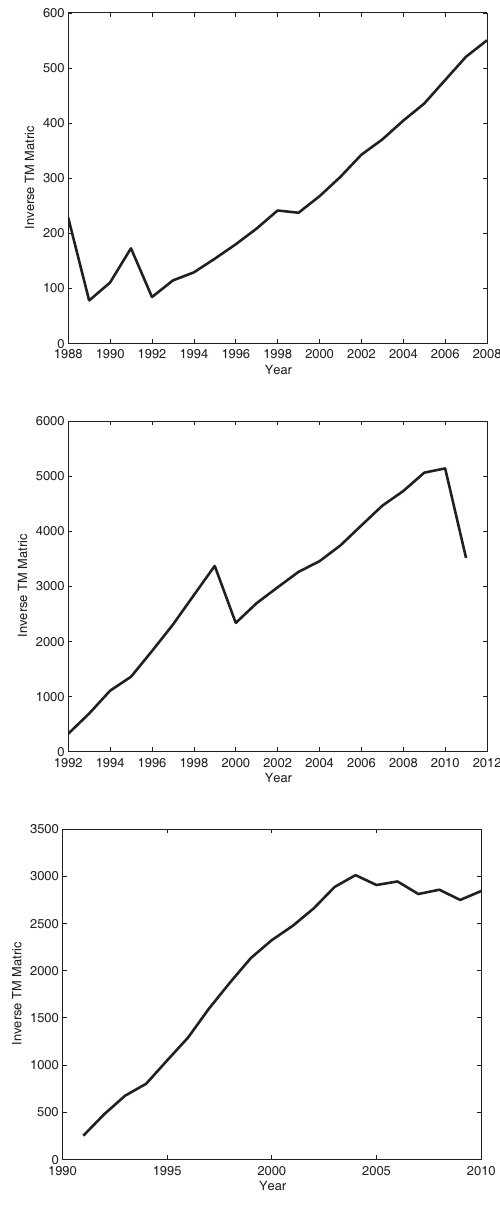
Fig. 13. Plot of inverse TM matric to measure ergodicity present Fig. 13. Plot of Inverse TM Matric to measure ergodicity present in true catalogs, (top) California catalog with magnitude threshold in true catalogs, (top) California catalog with magnitude threshold M ≥ 4, (middle) Japan catalog with M ≥ 5, (bottom) Indonesia cat- M ≥ 4 , (middle) Japan catalog with M ≥ 5 , (bottom) Indonesia alog with M ≥ 5. catalog with M ≥ 5 .